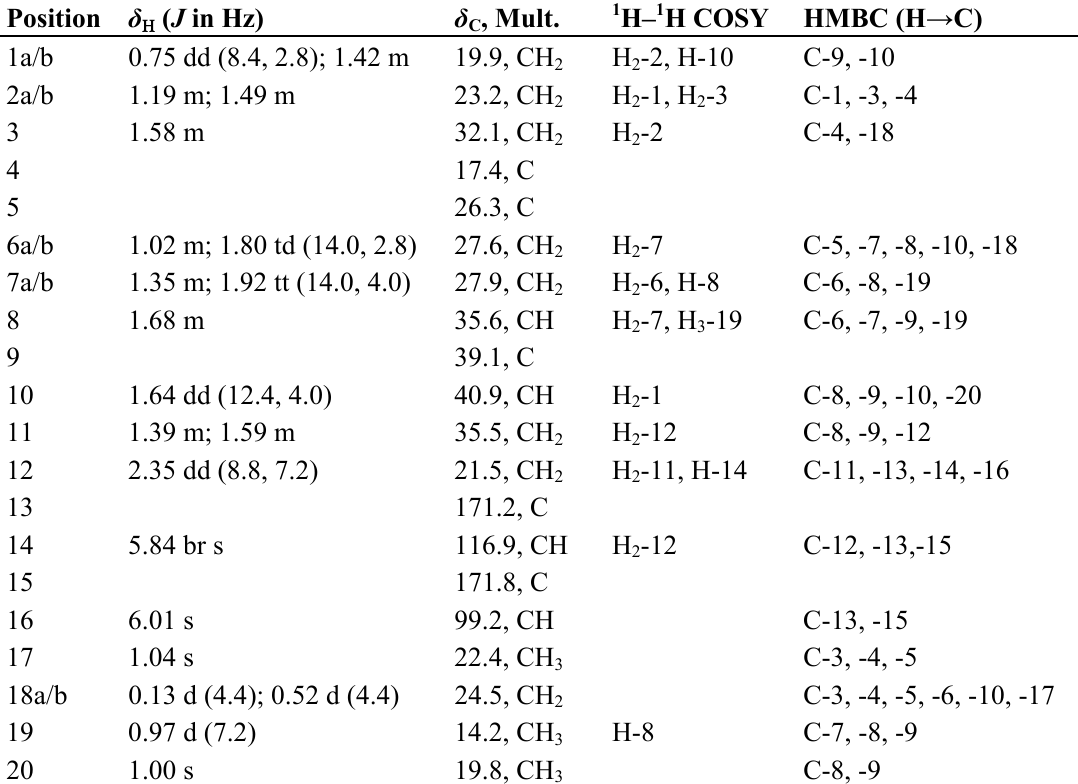
) NMR data, 1 H– 1 H COSY and 3